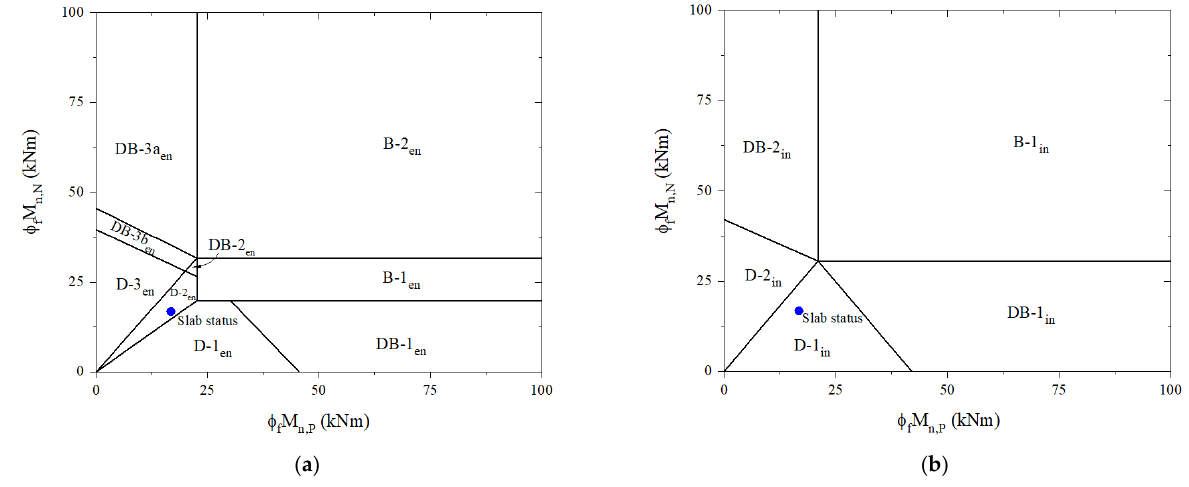
Figure 7. Predict failure mode based on moment-carrying capacities of the reference slab: ( a ) the end span; ( b ) the interior span. span; ( b ) the interior